Question: Which kind of chart has been used to present this data?
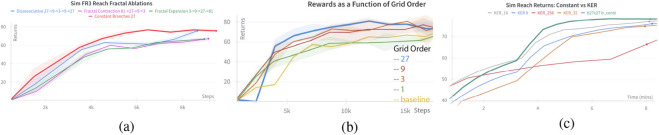
Answer: line